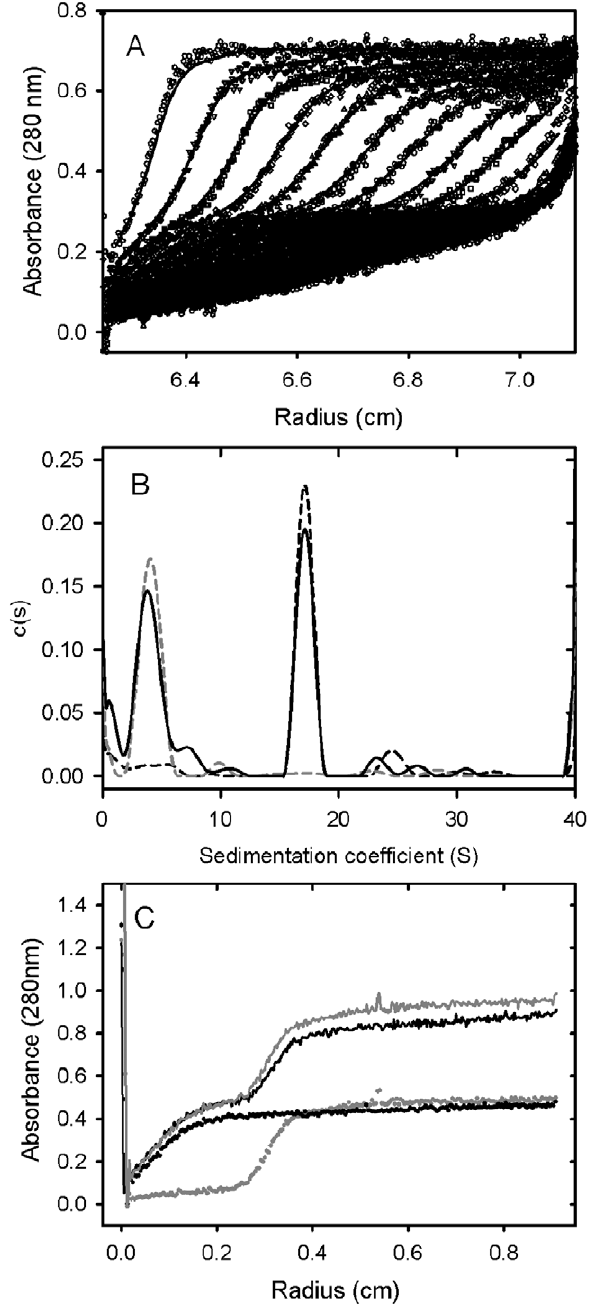
Figure 5. Sedimentation velocity analysis of a mixture of PAT- SM6 and GRP78. A. 0.4 mg/mL of PAT-SM6 and 0.4 mg/mL of GRP78 were incubated together and centrifuged at 28,000 rpm. The resulting sedimenting absorbance boundaries were monitored at 280 nm and representative data shown as open circles. Fits to the experimental data using a c(S) sedimentation model are shown as solid lines. B . Corresponding c(S) size distribution plots for the data presented in (A) for PAT-SM6 (black dashed line), GRP78 (grey dashed line) and the mixture of the two proteins (solid line). C. Radial distributions obtained after centrifugation at 28,000 rpm for 72 min for PAT-SM6 (0.4 m M; grey circles), GRP78 (10 m M; black circles) and mixture of PAT-SM6 (0.4 m M) and GRP78 (10 m M, solid line). The solid grey line is the sum of the radial distributions obtained for PAT-SM6 and GRP78 alone, assuming no interaction.